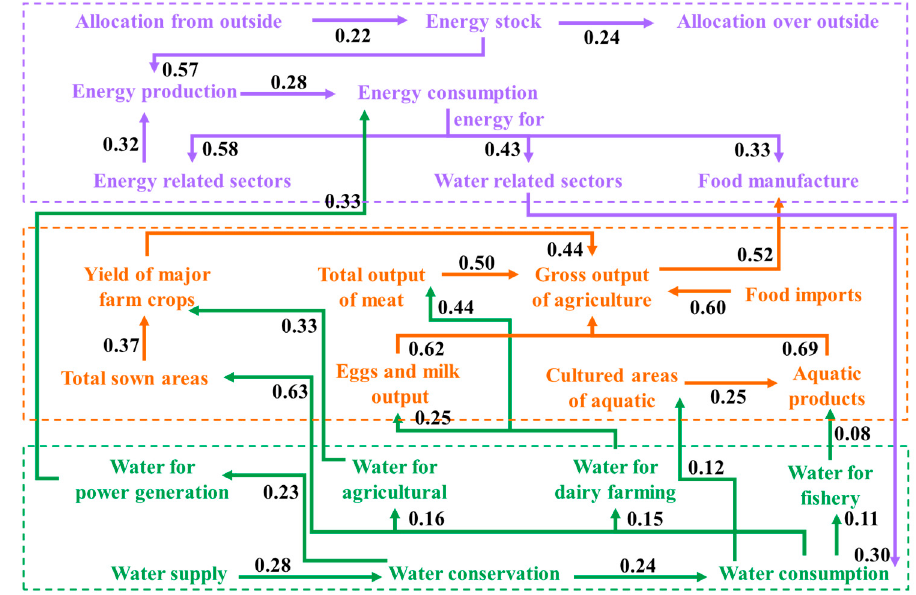
Figure 5. The causal path of order parameters and their synergy degree.